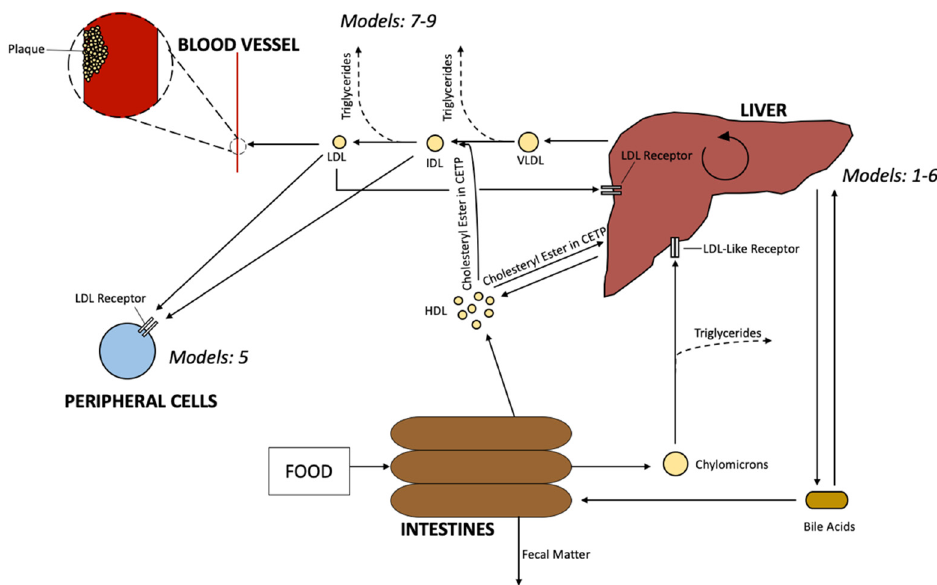
Figure 1. Diagram of cholesterol pathways. Movement of cholesterol is indicated by solid arrows. Dashed arrows indicate movement of other substances. Diagram is labeled to indicate where each model applies. Models 1–9 are listed in Table 1. Table 1. The models of cholesterol synthesis and metabolisms in liver as well as their type of model (Model numbers are the same as shown in Figure 1).